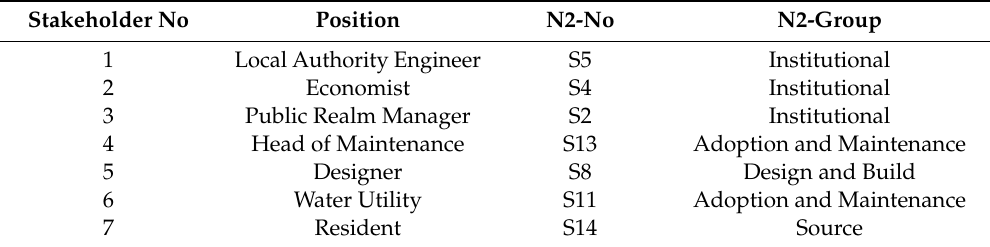
Table 2. List of stakeholders who participated in the survey and their associated group according to the N2